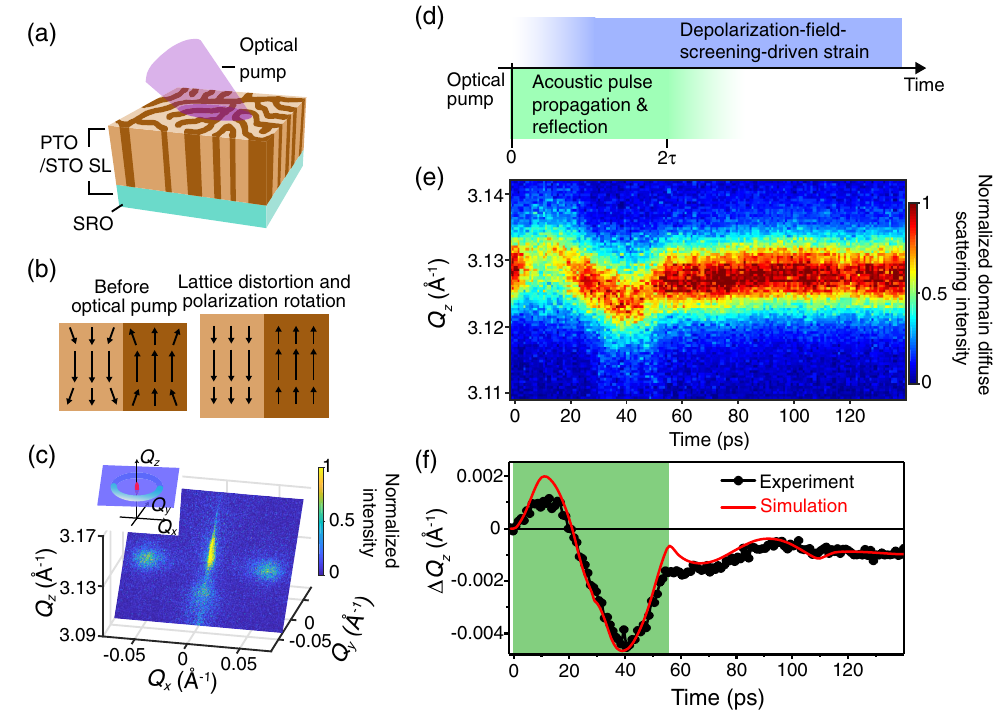
FIG. 1. Photoinduced picosecond dynamics in nanodomains. (a) Femtosecond optical excitation of ferroelectric nanodomains. (b) Mechanisms of polarization distortion accompanying expansion following optical excitation. (c) Slice of reciprocal space near the 002 reflection at t < 0 . The diffuse scattering intensity at Q x ¼ (cid:2) 0 . 054 Å − 1 arises from the nanodomain pattern. (d) Timeline of structural effects induced by optical excitation: acoustic propagation and reflection and depolarization-field-screening-driven strain. (e) Normalized domain diffuse scattering intensity as a function of Q z following optical excitation at t ¼ 0 . The intensity was normalized with respect to the intensity at t < 0 . (f) Measured (points) and simulated (line) shift Δ Q z of the peak out-of-plane wave vector of the maximum domain diffuse